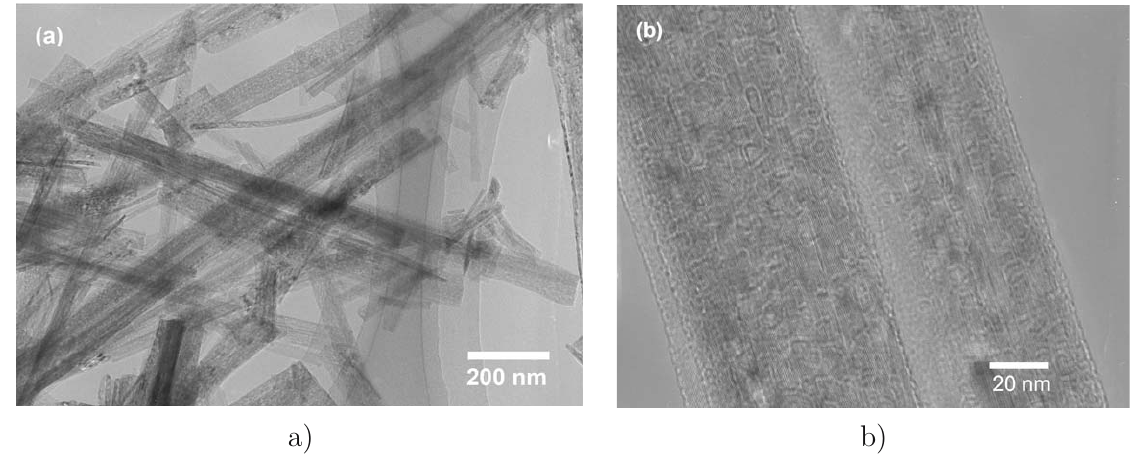
Fig. 4 TEM images of TiO 2 (B) nanowires: (a) low magnification, showing plenty of internal defects, (b) HR-TEM image of a bundle (two parallel nanowires), demonstrating the single-crystal nature of each wire with mosaic structure.